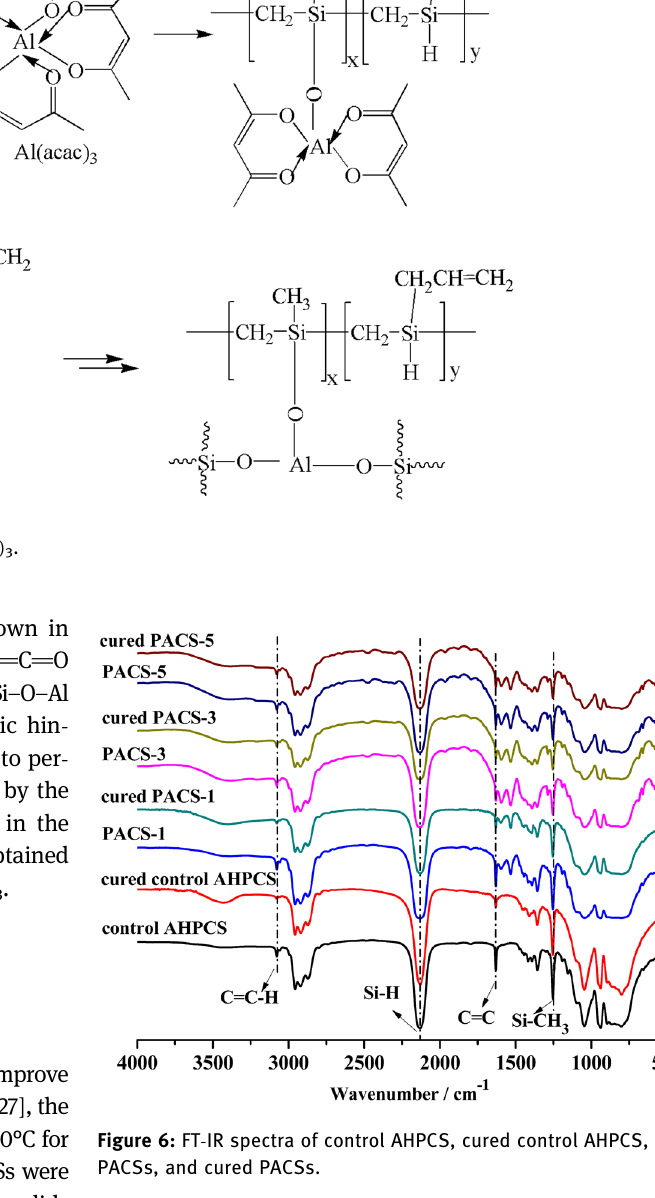
Figure 6: FT - IR spectra of control AHPCS, cured control AHPCS, PACSs, and cured